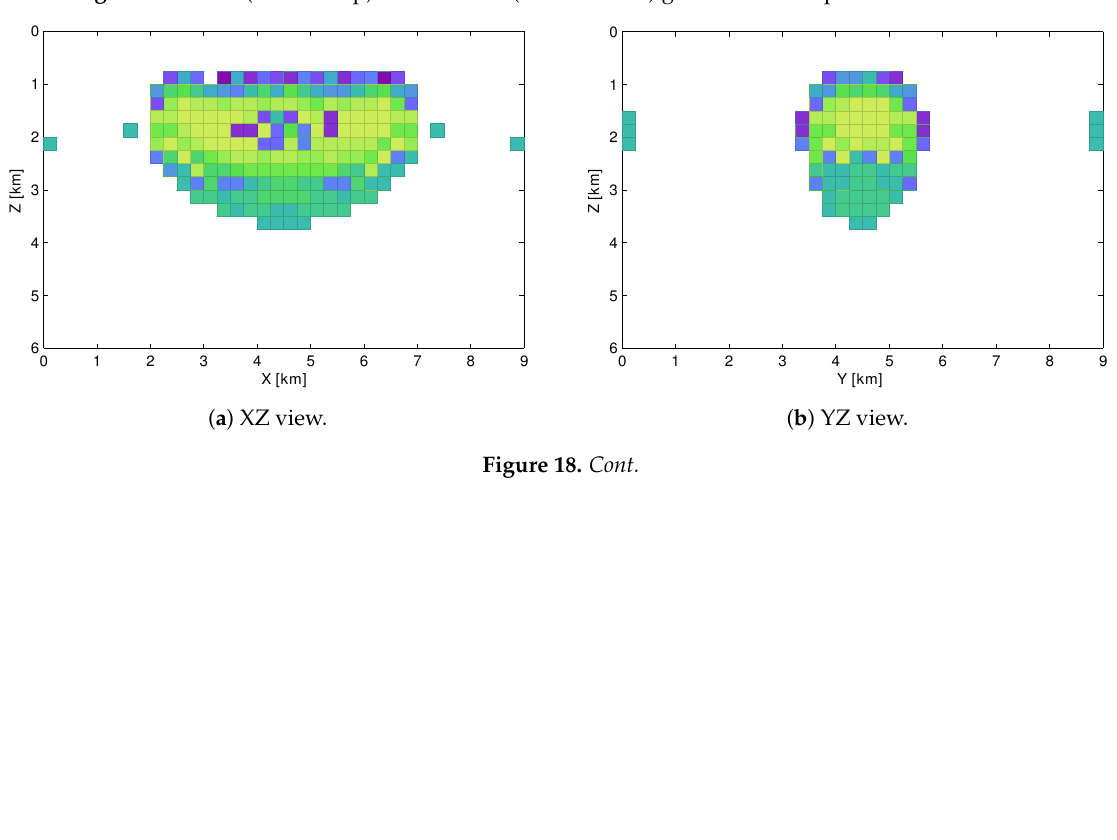
Figure 17. Initial (colour map) and inverted (contour lines) gradiometric response for the T model.